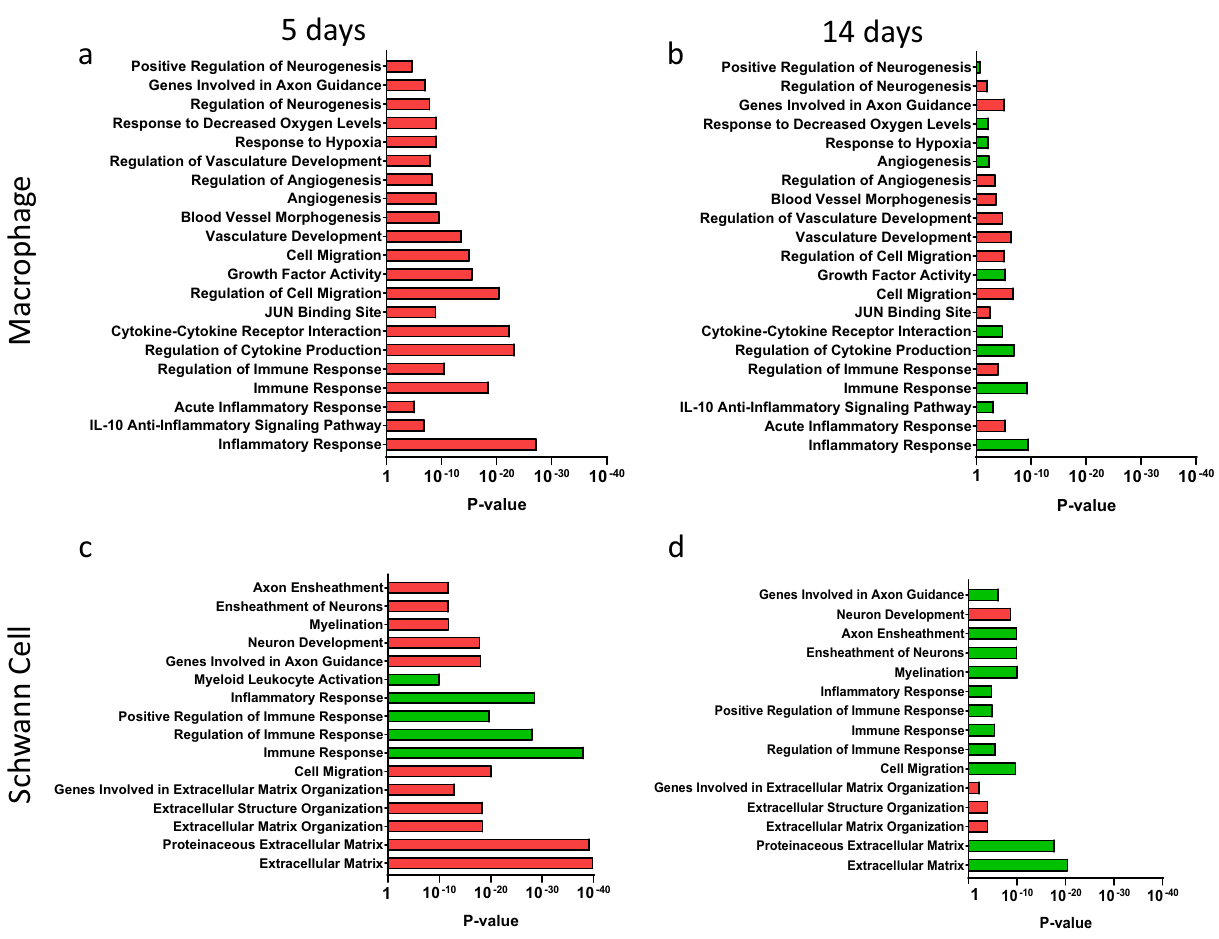
Fig. 2 Delayed repair further delays regeneration. Downregulation (red) of immune response, angiogenesis, and IL10 signaling pathways identi fi ed in macrophages at day 5 was identi fi ed, followed by upregulation (green) of these biogroups at day 14. In SC, extracellular matrix formation, cell migration, and myelination were downregulated at day 5 compared to day 14 demonstrating the extension and progressive worsening of the repair process when repair is delayed. RNA sequencing data from delayed CP-TIB graft vs immediate CP-TIB graft for macrophages ( a , b ) and Schwann cells ( c , d ) after repair shows downregulation (red) or upregulation (green) of genes in biogroups at ( a , c ) day 5 or ( b , d ) day 14 after delayed repair. Cells isolated using FACS. n = 8 animals (4 male, 4 female) per group per time